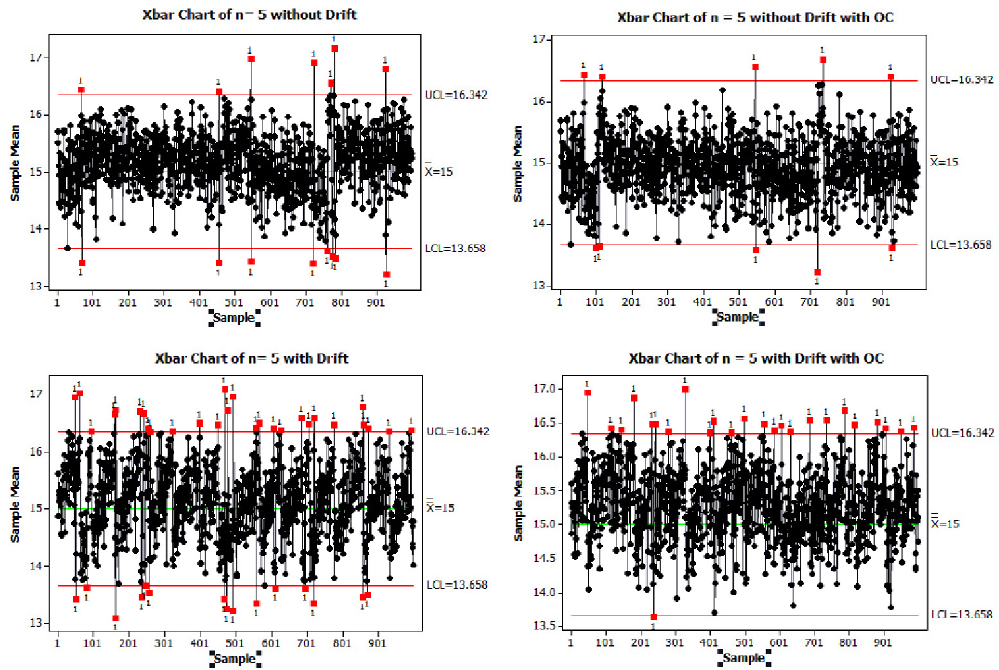
Fig. 7. n = 5 – Shewhart chart for the first 1000